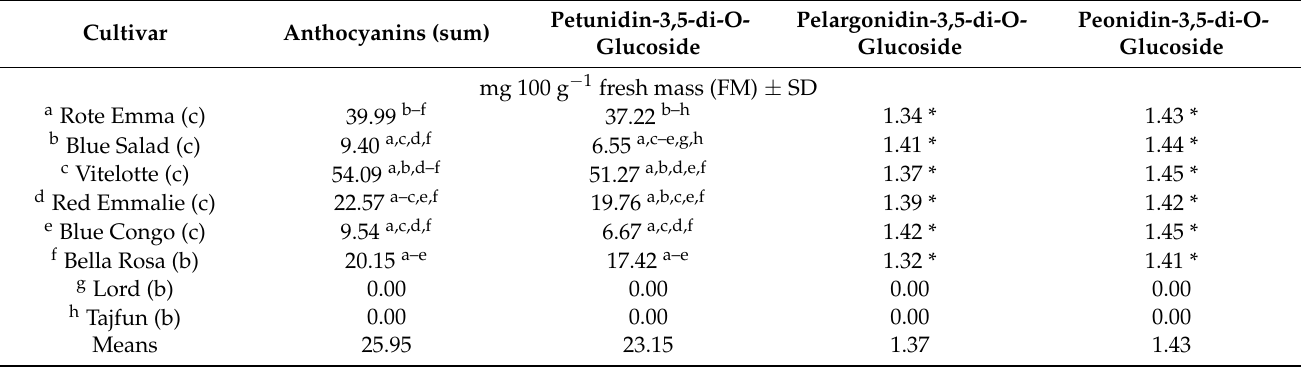
Table 4. Anthocyanin content in coloured- and bright-fleshed potato tubers (mg 100 g − 1 FM). Cultivar Anthocyanins